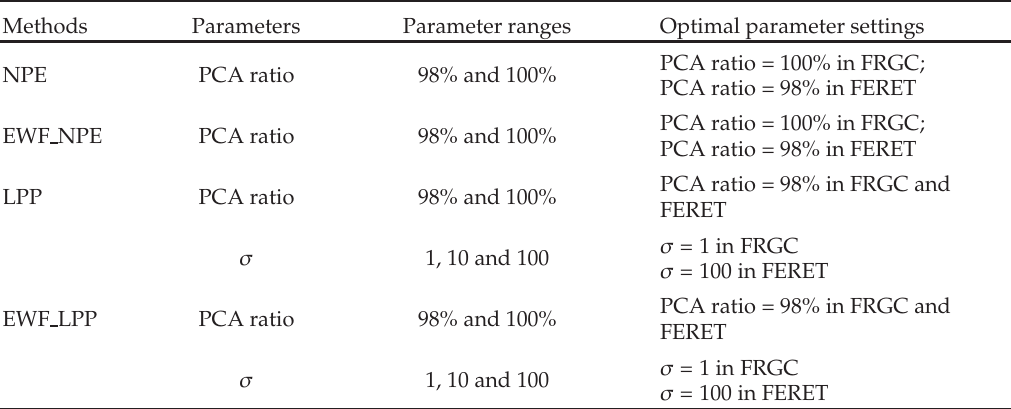
Figure 13: Error rates (cid:2) % (cid:3) of (cid:2) a (cid:3) PCA, NPE and EWF NPE, (cid:2) b (cid:3) PCA, LPP and EWF LPP on FERET database. Table 2: Parameter ranges used in the